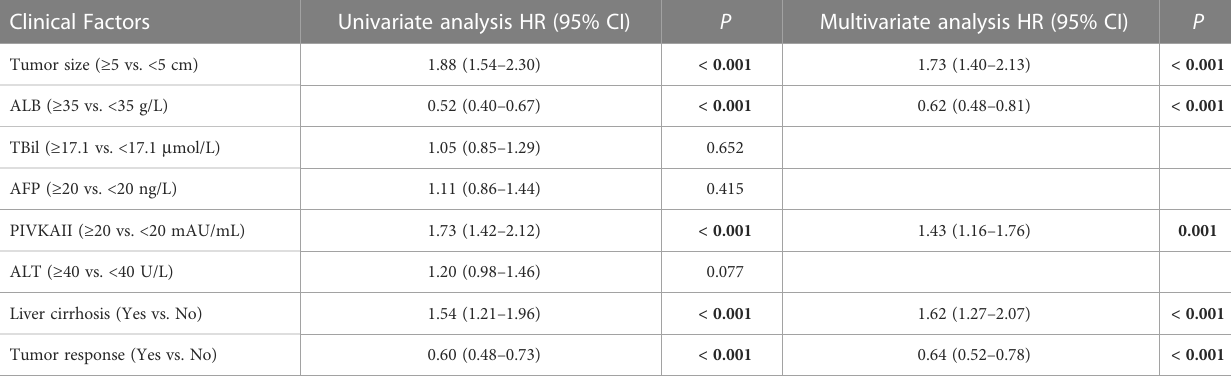
TABLE 3 Univariate and multivariate Cox regression analysis to identify independent prognostic factors of OS in advanced ICC patients treated with Camrelizumab and GEMOX. Clinical Factors